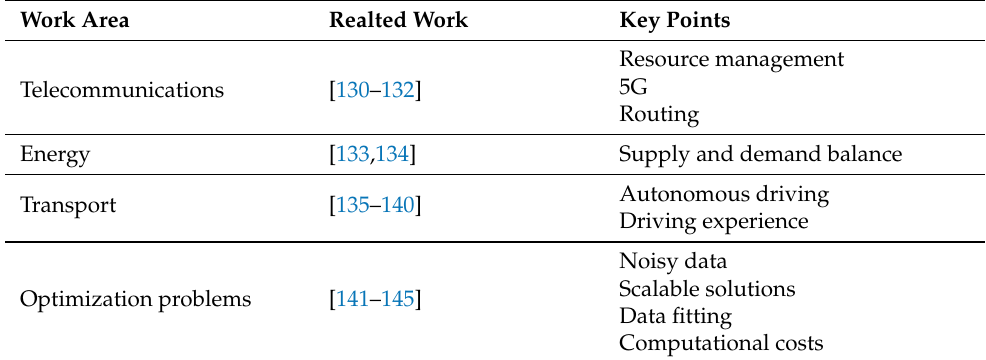
Table 6. Studies supported by reinforcement learning.